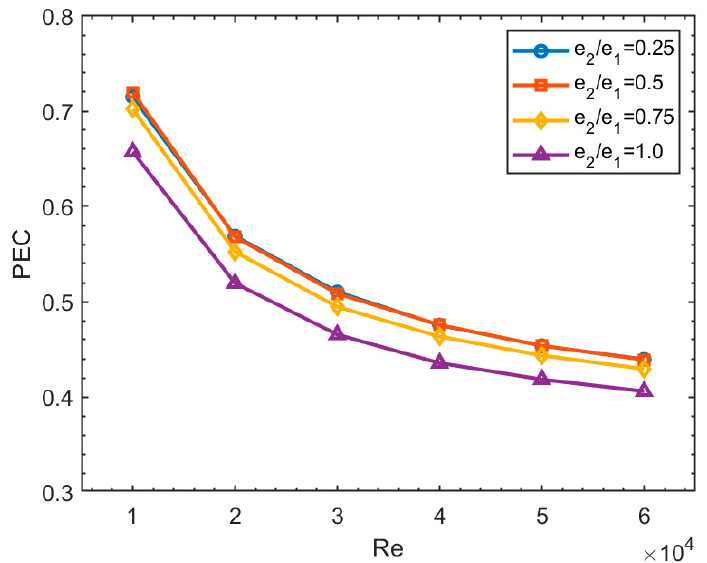
Figure 11. The performance evaluation criterion, PEC, changes with Re at different rib height ratios e 2 /e 1 and Pr = 7.0.